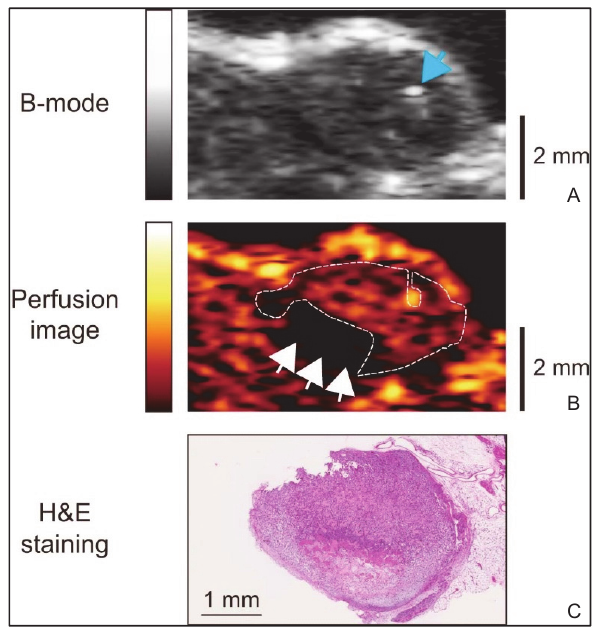
Figure 10 The region of interest (ROI) was drawn on the SK-OV-3 tumors manually so as not to encompass the areas with excessive signal intensity or perfusion defects. (Reprinted with permission from reference [45])